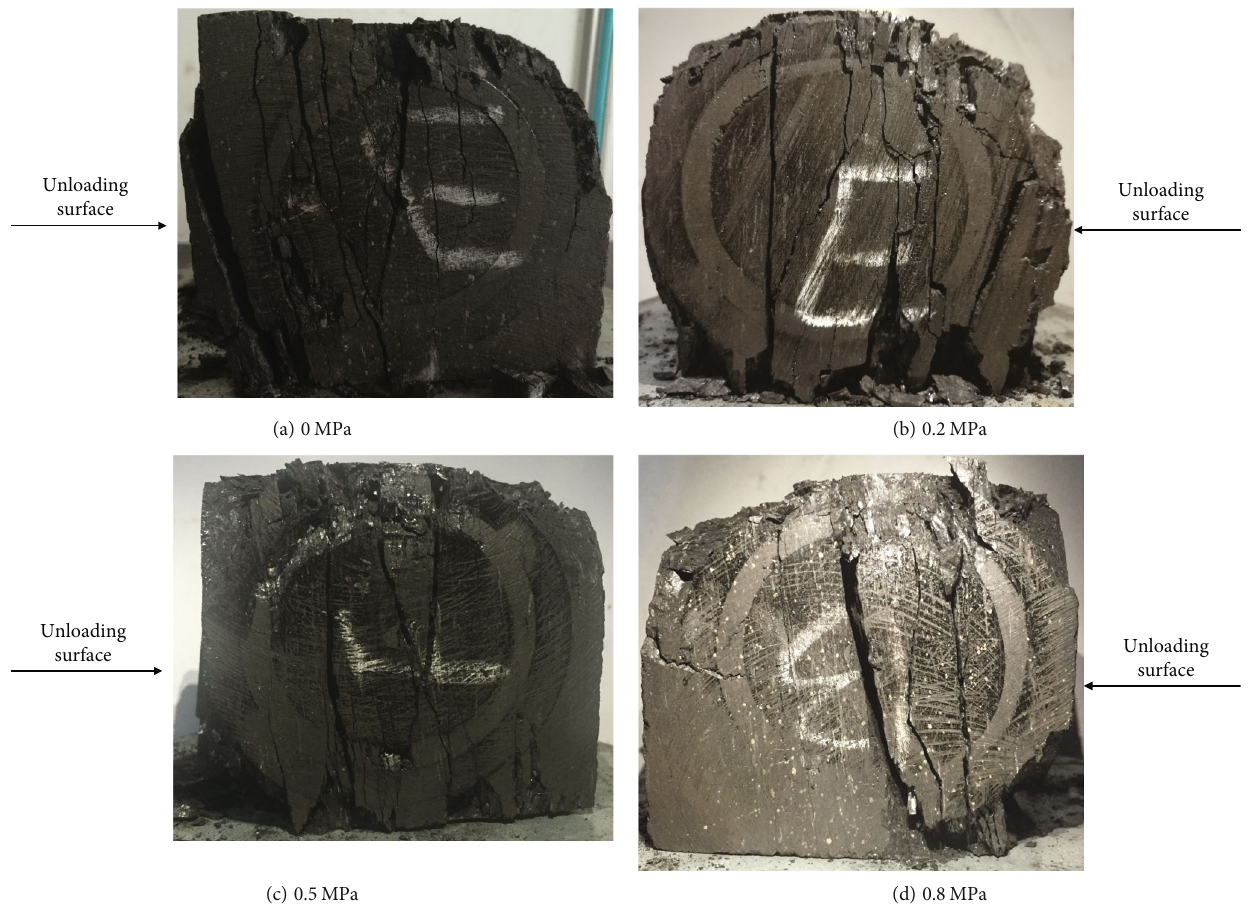
Figure 4: Failure modes of coal samples under di ff erent gas